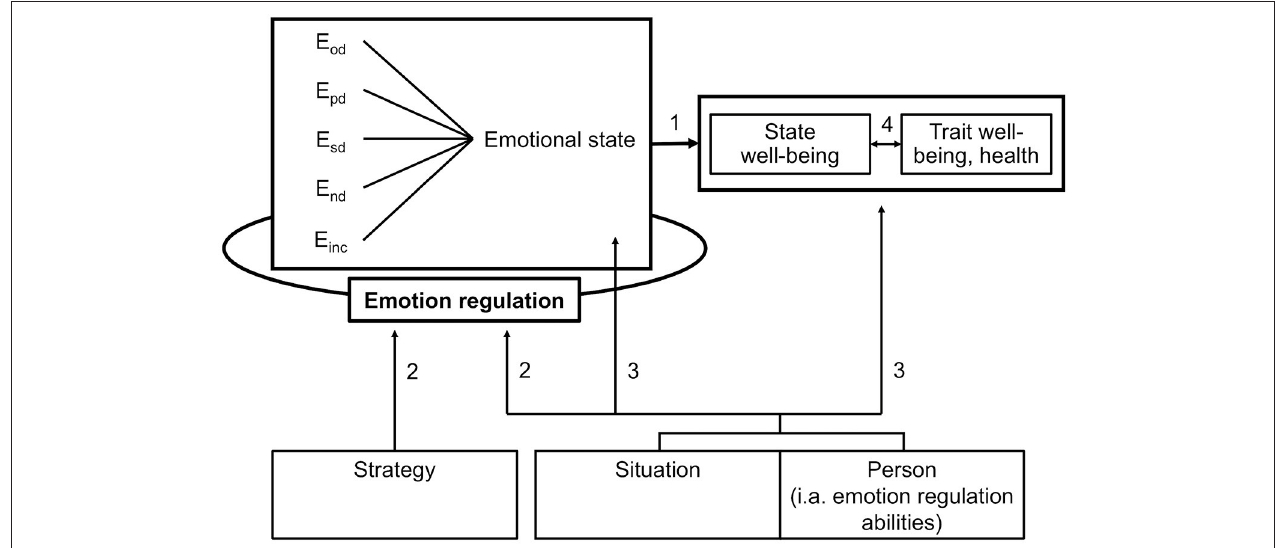
FIGURE 2 | Model for emotions and emotion regulation in provider-client interactions, part 2: Emotion regulation, well-being, and influencing factors. E od , emotions elicited by object-directed interpersonal emotion transfer; E pd , emotions elicited by person-directed interpersonal emotion transfer; E sd , emotions elicited by self-directed interpersonal emotion transfer; E nd , emotions elicited by emotion contagion (non-directed); E inc , emotions elicited otherwise